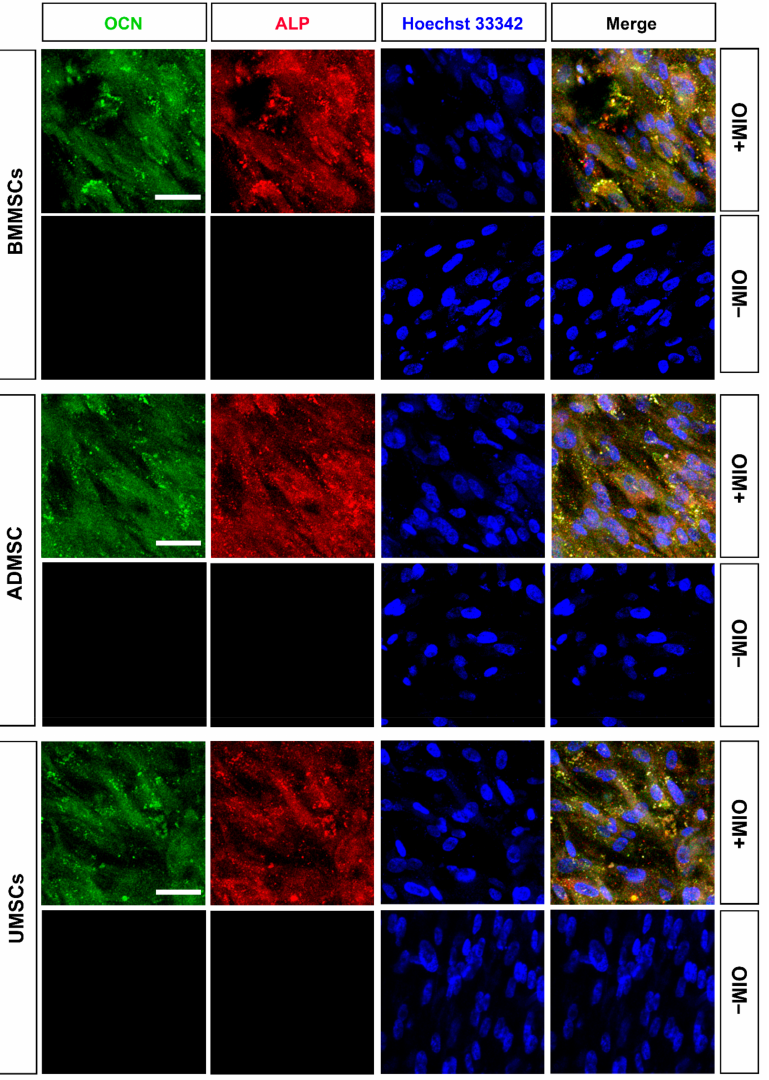
Figure 3. Characterization of osteogenesis of hMSCs on hDCB blocks. The hMSCs of three origins were seeded onto hDCB blocks, treated with or without an osteogenic differentiation medium for 14 days (OIM+ and OIM − , respectively), and then stained with osteocalcin (OCN) and alkaline phosphatase (ALP) antibodies to evaluate the expression of osteogenic proteins. Green, red, and blue represent OCN, ALP, and nuclei, respectively. Scale bars are 50 µ